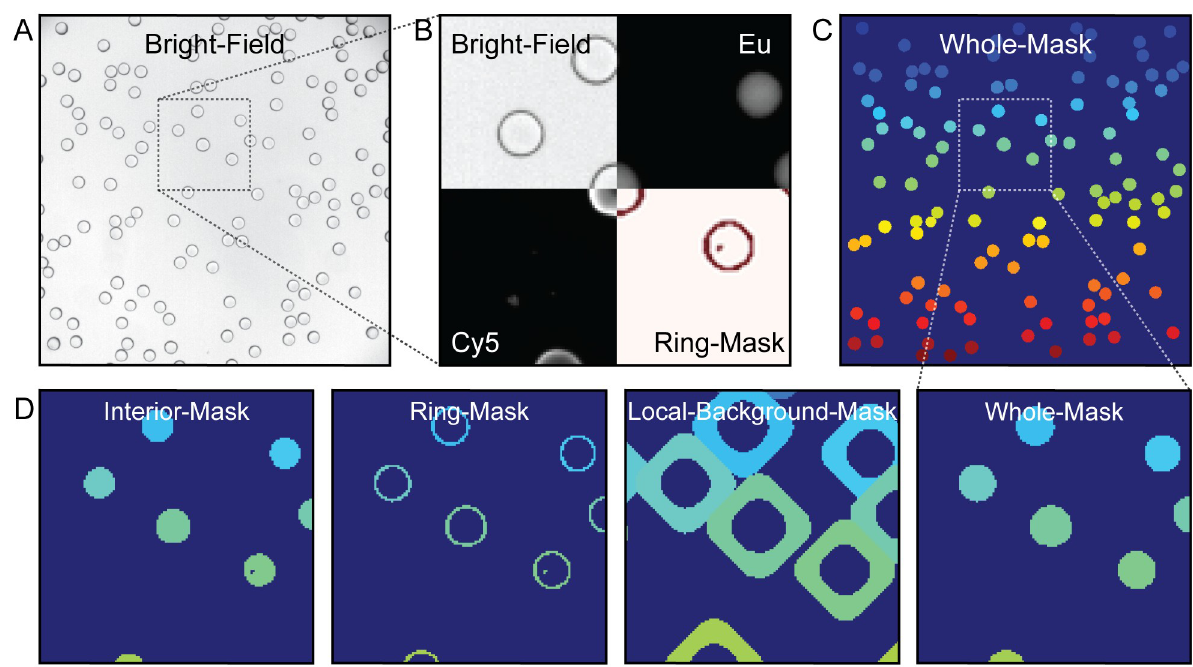
Fig 3. Images depicting the overlay of the assay region and various channels. A) bright-field image used for find the beads; B) cut-outs of fluorescent (Cy5) channel, bright-field, found ring region, and unmixed Europium channel; C) final mask depicting the whole region of each individual bead; D) zoomed-in region of the different mask regions generated from the mrbles.Find class. The color (a unique number) indicates the distinct region for one particular MRBLE. This color matches among the different masks and is unique to each identified MRBLE in these images. Dark blue represents the